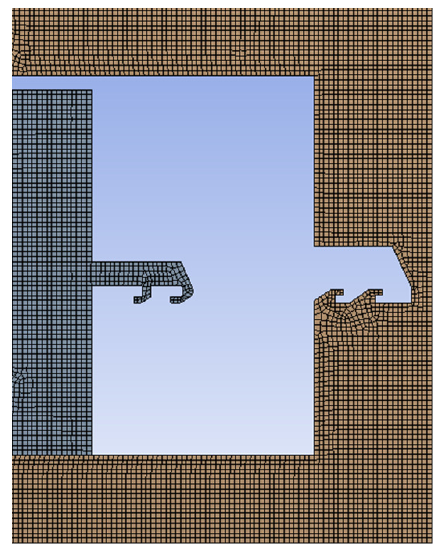
Figure 16. Finite element model.